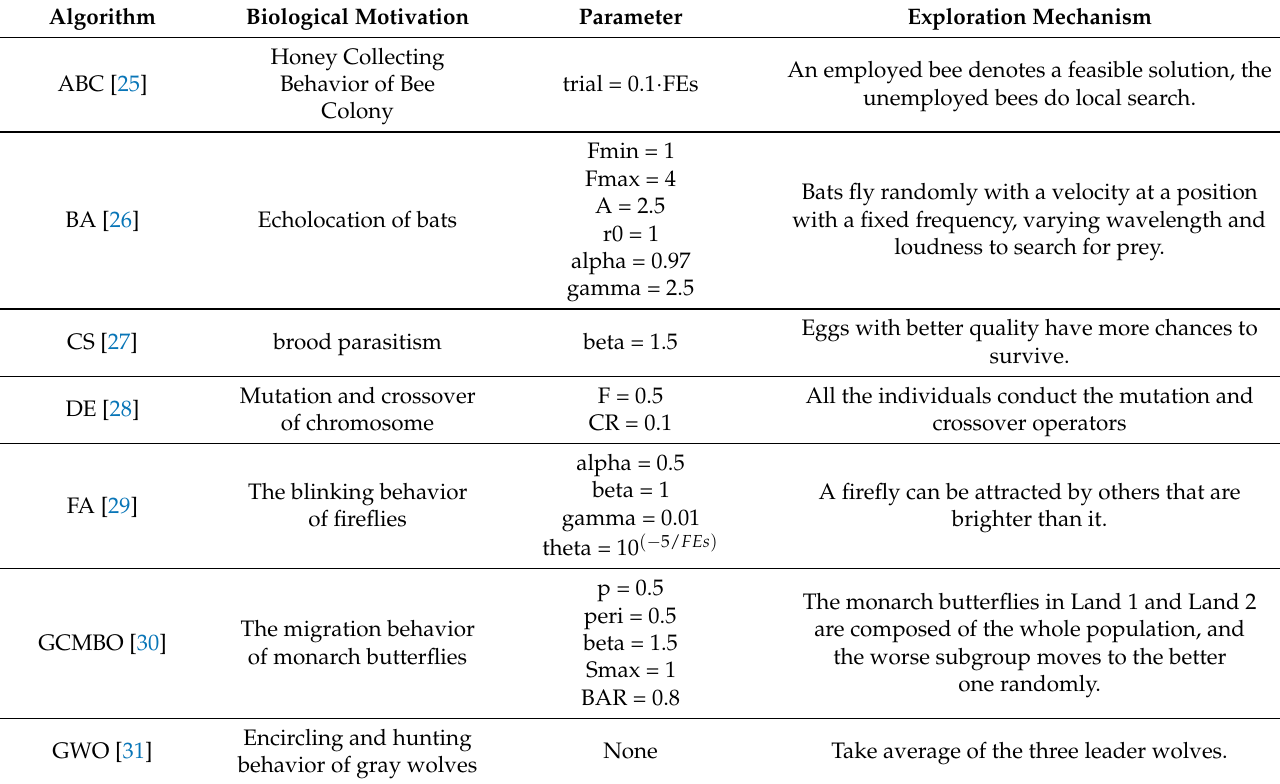
Table 1. An algorithmic parameter summary of twelve swarm intelligence (SI) algorithms.